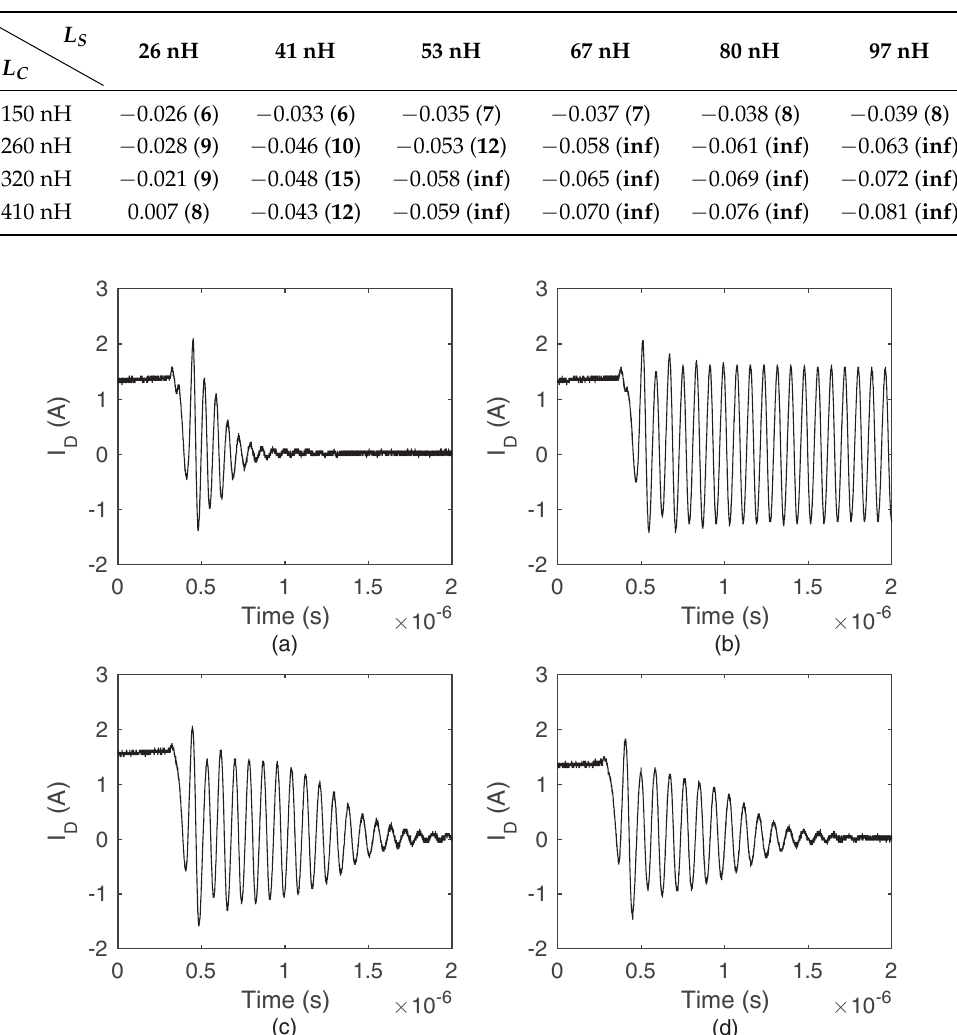
Table 4. A comparison between the ζ 1 and number of oscillation cycles N C ( bold ) with various L C and L S with R G = 2 Ω .